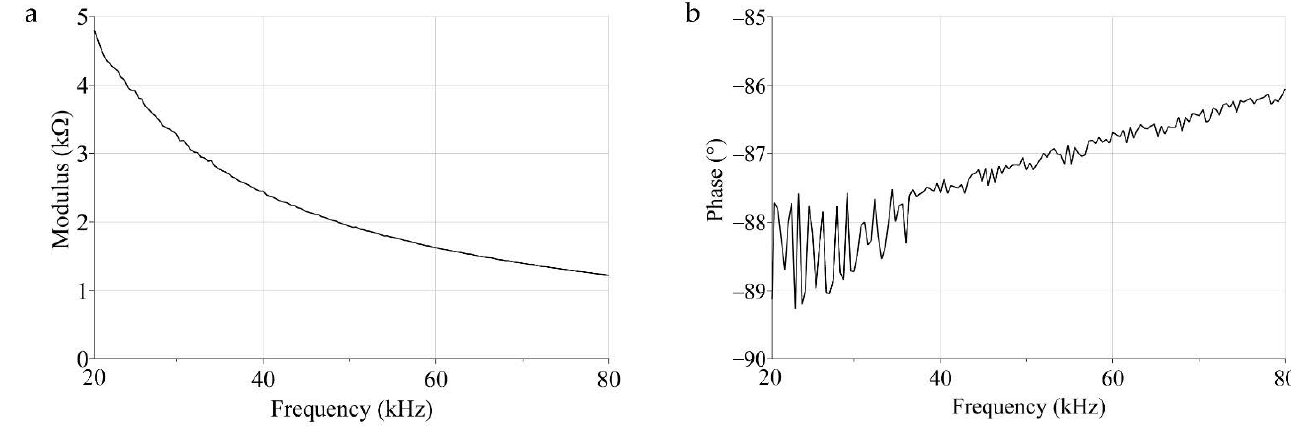
Figure 8. Electrical impedance magnitude ( a ) and phase ( b ) of the proposed PVDF sensor.